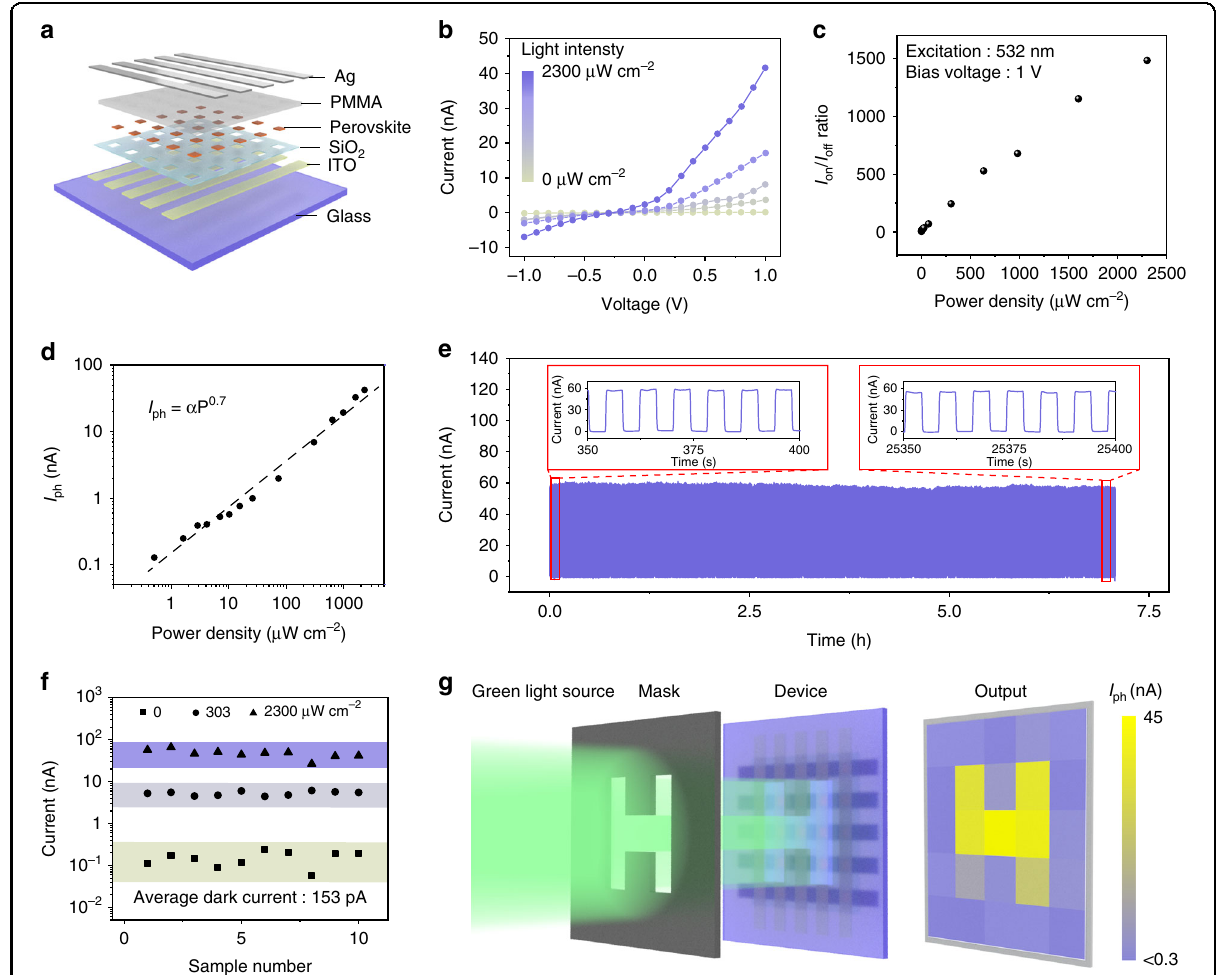
Fig. 5 Vertically structured photodetector array based on the MAPbBr3 MPs. a Schematic illustration of the device structure of the photodetector array. b I-V curves of the device measured under the 532 nm illumination with light intensity from 0 to 2300 μ W cm − 2 . c I on /I off ratio as a function of the light intensity. d The dependence of I ph on the light intensity. e Stability of the device after continuous operation for 7 h. f Dark current and photocurrent of 10 pixels in a photodetector array. g Light intensity distribution imaging through mapping the photocurrent of the photodetector